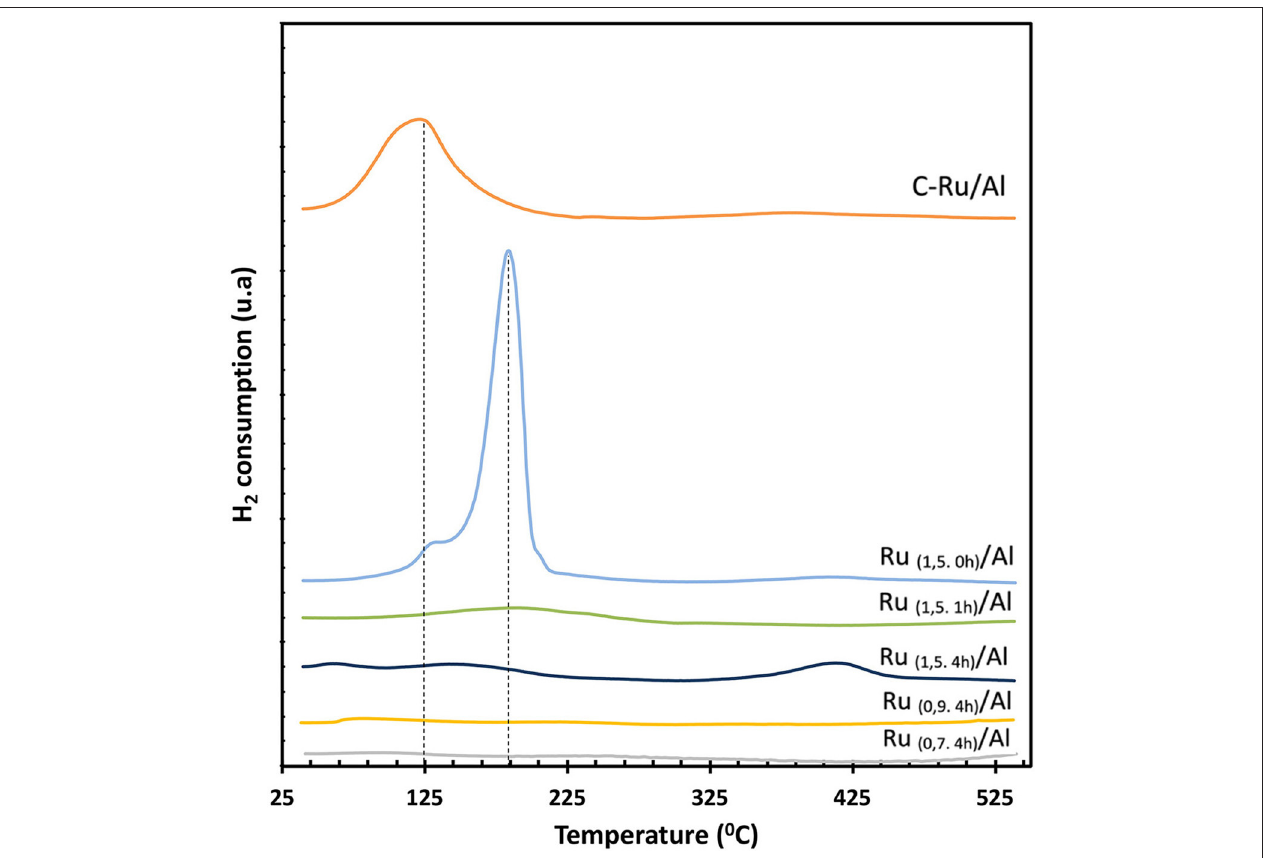
FIGURE 4 | H 2 -TPR profiles for commercial and synthesized Ru/Al